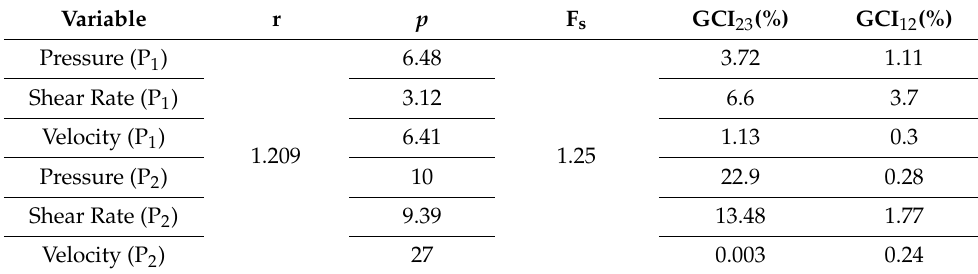
Table 5. Grid convergence index for different variables.